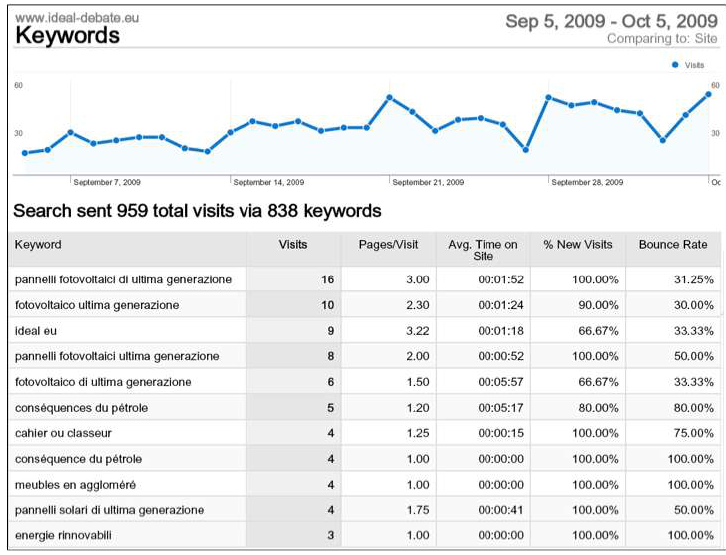
Figure 8: SNP indicators (September